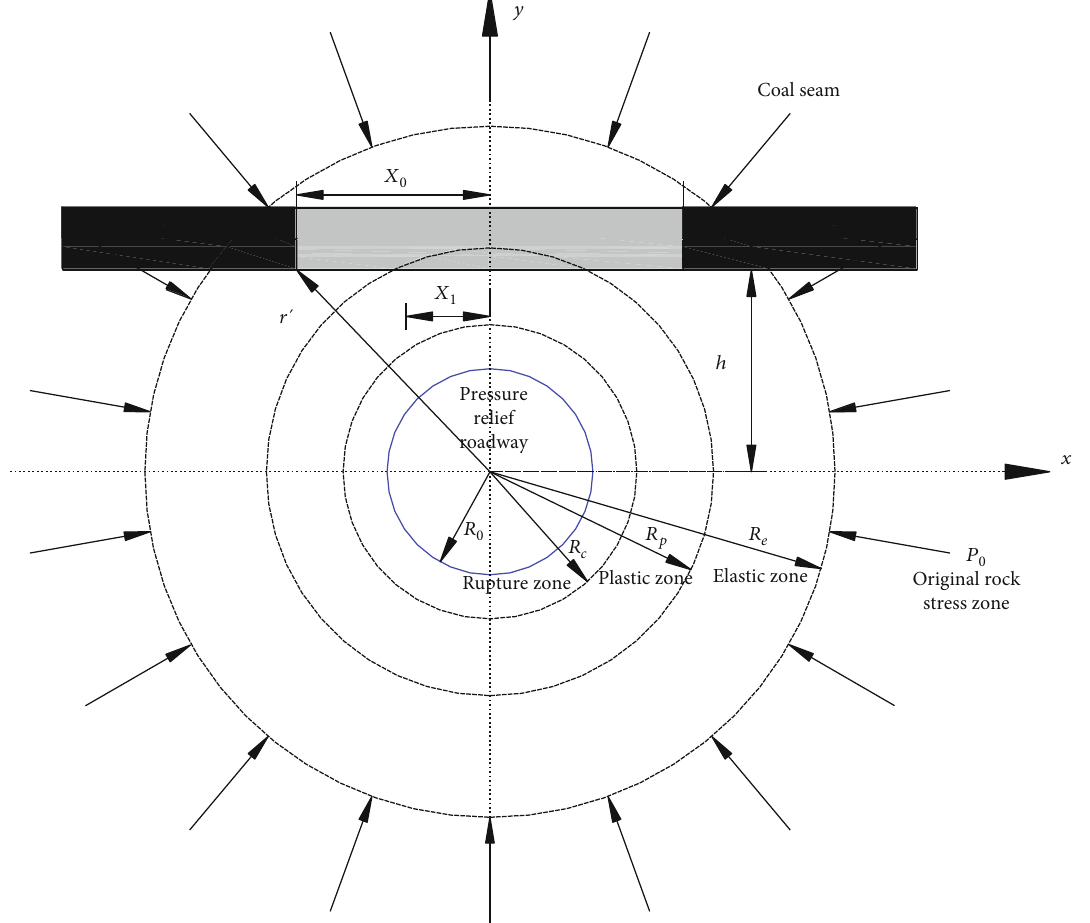
Figure 3: Calculation model of coal seam permeability enhancement.